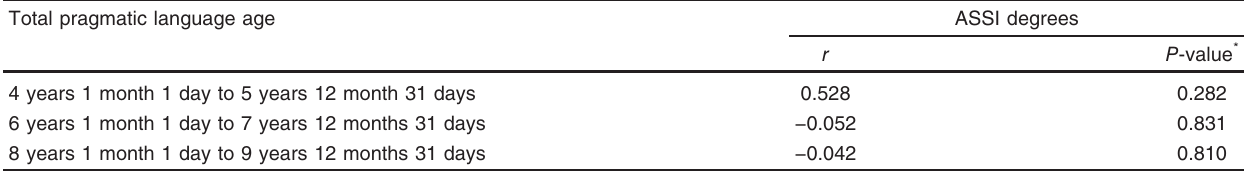
Table 15 Correlation between degrees of the Stuttering Severity Instrument for Children and Adults − Arabic version, and total pragmatic language age in each age group, using Pearson ’ s correlation